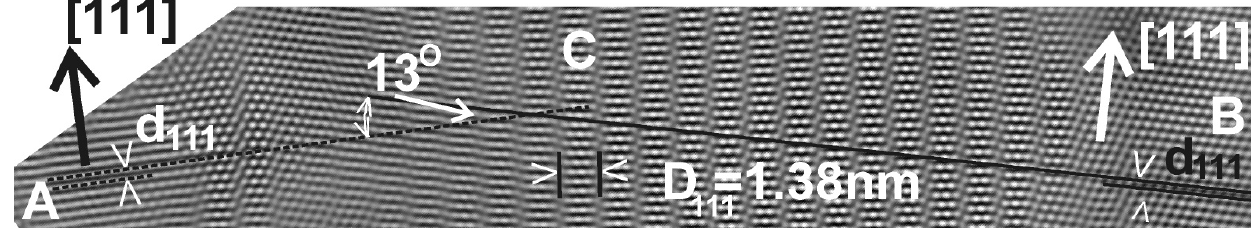
Figure 6. High-resolution TEM micrograph from two partially overlapping [111] type whiskers A and B; the overlapping area is denoted by the letter C. The observed rotational Moiré pattern has a periodicity of D 111 = 1.38 nm. Another example of two partially overlapping parallel whiskers, A and B, is shown